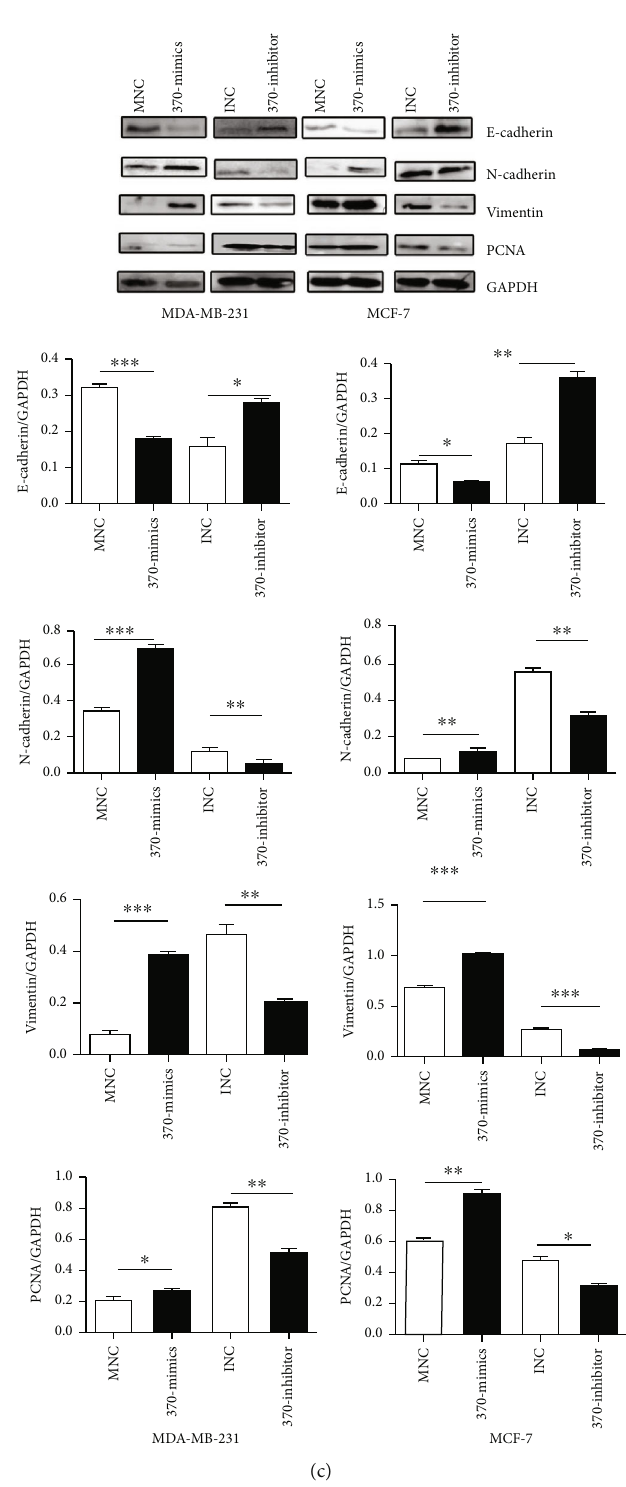
Figure 1: miR-370-3p can promote migration and proliferation of breast cancer cells in vitro . (a) Transwell migration assay was used to evaluate the migration of miR-370-3p in breast cancer cells (MDA-MB-231 and MCF-7). ∗∗∗ P < 0 : 001 . The scale bar is in the upper right of the fi rst picture in each row. (b) Evaluation of miR-370-3p on proliferation of breast cancer cells (MDA-MB-231 and MCF-7) by colony forming assay. ∗∗ P < 0 : 01 , ∗ P < 0 : 05 . (c) Western blot was used to detect the expression of EMT-related proteins and PCNA protein of miR-370-3p in breast cancer cells (MDA-MB-231 and MCF-7). ∗∗∗ P < 0 : 001 , ∗∗ P < 0 : 01 , ∗ P < 0 : 05